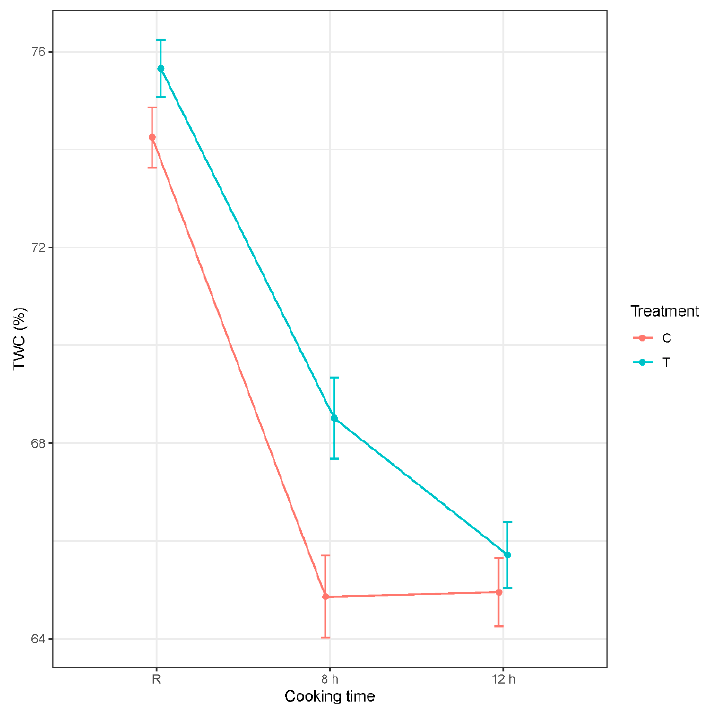
Figure 4. Effect of injection treatment (T = Injection with 2 g/L GP solution containing zingibain; C = control/without injection) and cooking time (8 h, 12 h) on total water content (TWC) of M. biceps femoris cooked at 65 °C under sous vide. Values are presented as mean ± SE for raw (R) and cooked meat samples.